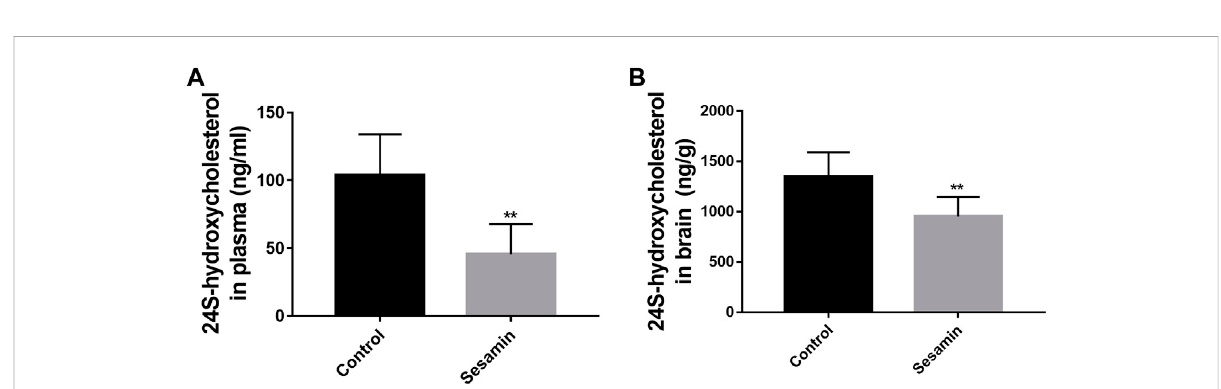
FIGURE 8 Changesinthelevelsof24S-hydroxycholesterolinratplasma (A) andbraintissues (B) aftertreatmentwithsesamin.Datawereanalyzedbyone- way ANOVA and unpaired t-tests and are presented as mean ± SD from fi ve experiments carried out in duplicate. ** p < 0.01 compared with control.